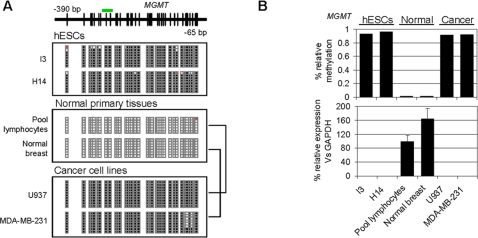
Promoter DNA hypermethylation and repression of MGMT in hESCs.(A) Bisulfite genomic sequencing of multiple clones of the MGMT promoter in hESCs (I3, H14), normal primary tissues (Pool lymphocytes, normal breast) and two CCLs of lymphoid and breast origin (U937 and MDA-MB-231, respectively). Black, methylated CpG; white, unmethylated CpG; red, CpG not present. The green bar above the diagram of the MGMT CpG island indicates the location of the probe used in the methylation arrays. (B) Relationship between MGMT promoter hypermethylation and expression in hESC, normal, and cancer samples. The upper panel shows the relative methylation signal obtained with the methylation arrays and the lower panel the expression levels of MGMT mRNA relative to GAPDH.